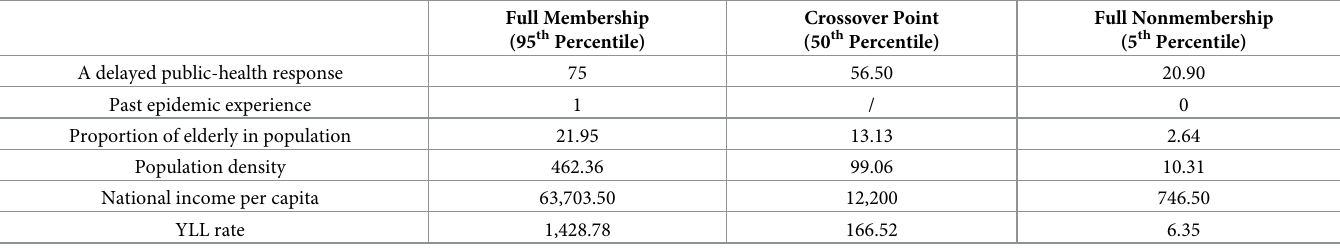
Table 2. Calibration